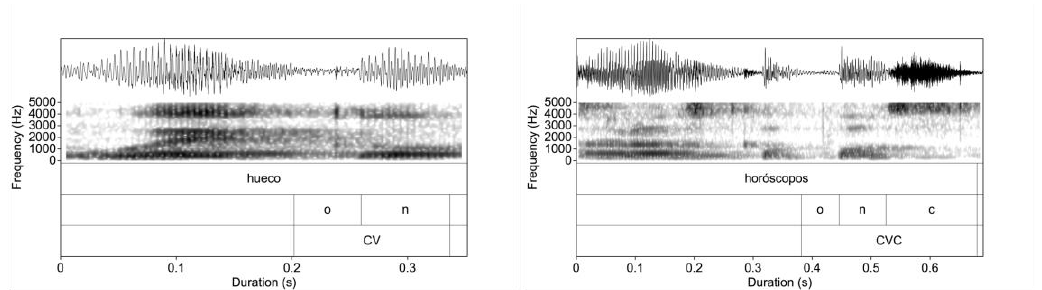
Source: Google maps Figure 3. Segmentation in the final CV syllable of hueco (left panel) and final CVC syllable of horóscopos (right panel) where ‘o’ denotes ‘onset’, ‘n’ denotes ‘nucleus’ and ‘c’ denotes